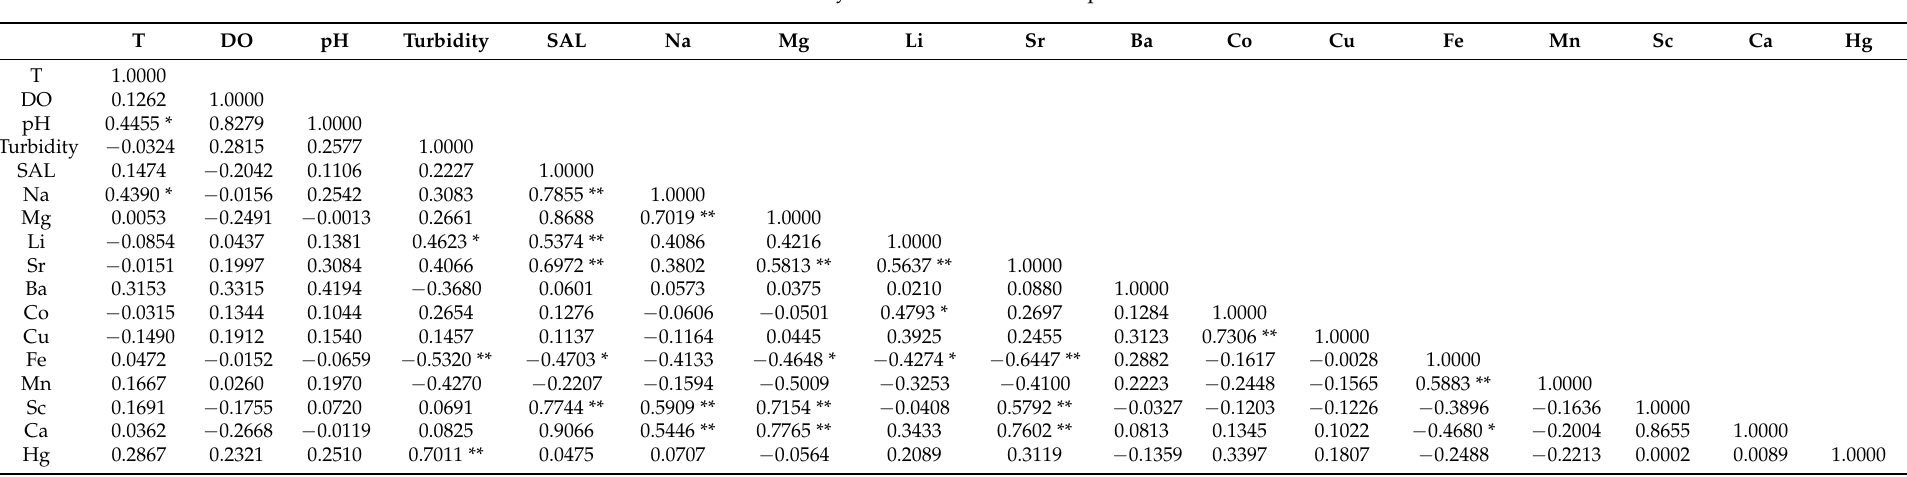
Table 5. Pearson correlation coefficient matrix of analyzed variables for 19